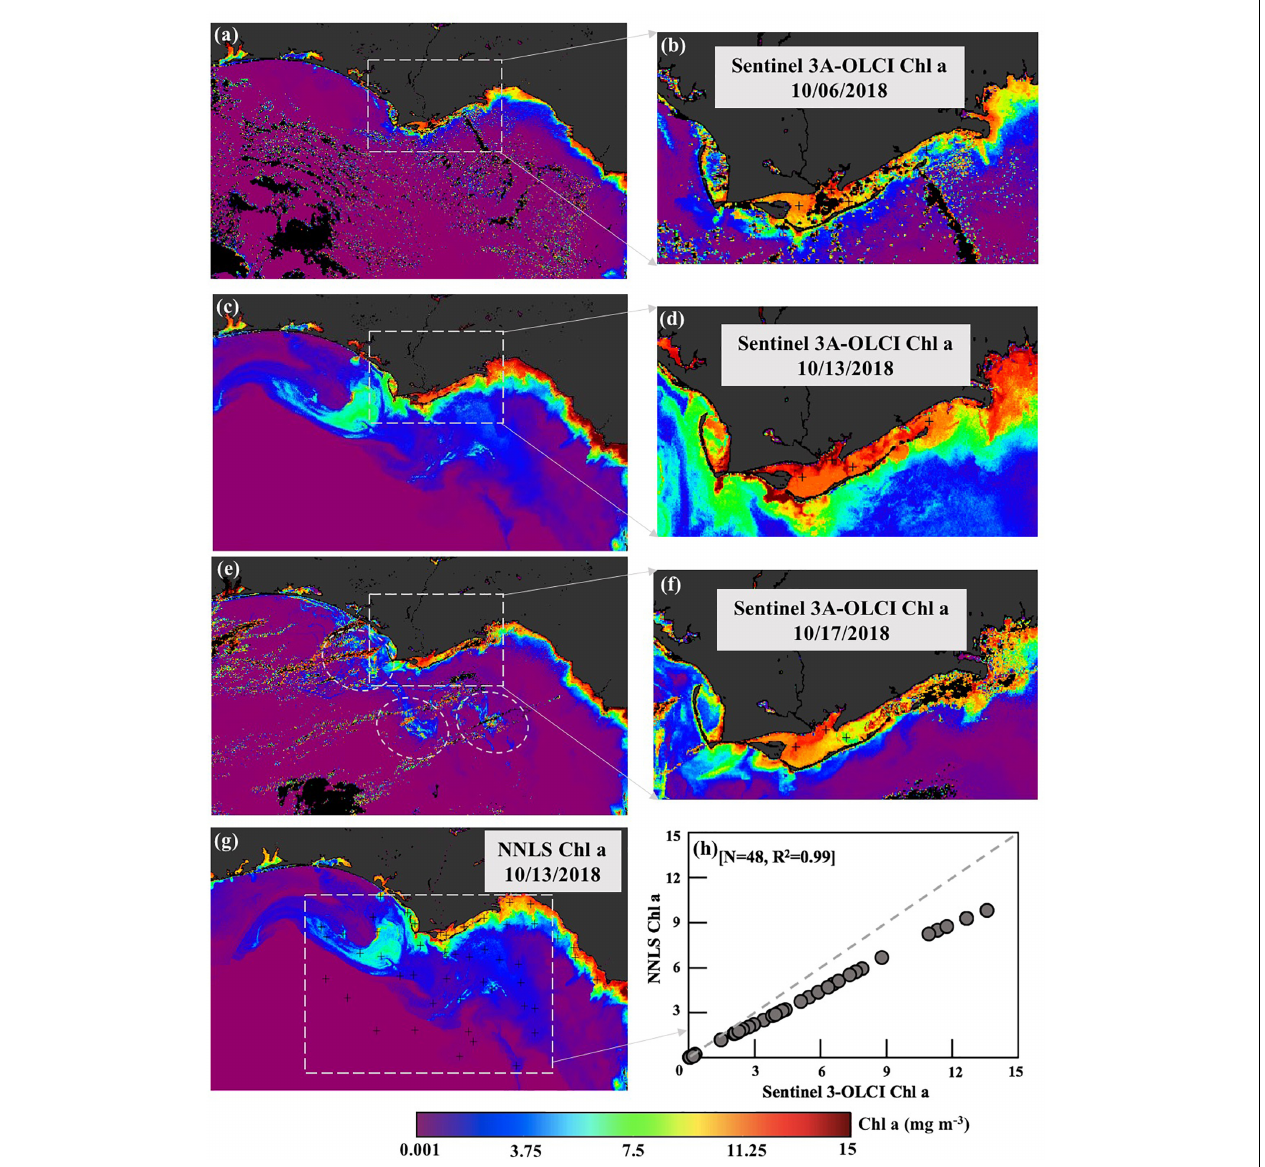
FIGURE 11 | Sentinel-3A OLCI-derived Chl a maps. (a,c,e) Chl a standard product of shelf waters for 06, 13, and 17 October 2018 with corresponding maps (b,d,f) of ApB and nearshore coastal waters. (g) Total Chl derived from the NNLS inversion algorithm for October 13, 2018; (h) comparison of OLCI-derived Chl a standard product vs. NNLS-derived Chl a for October 13, 2018.